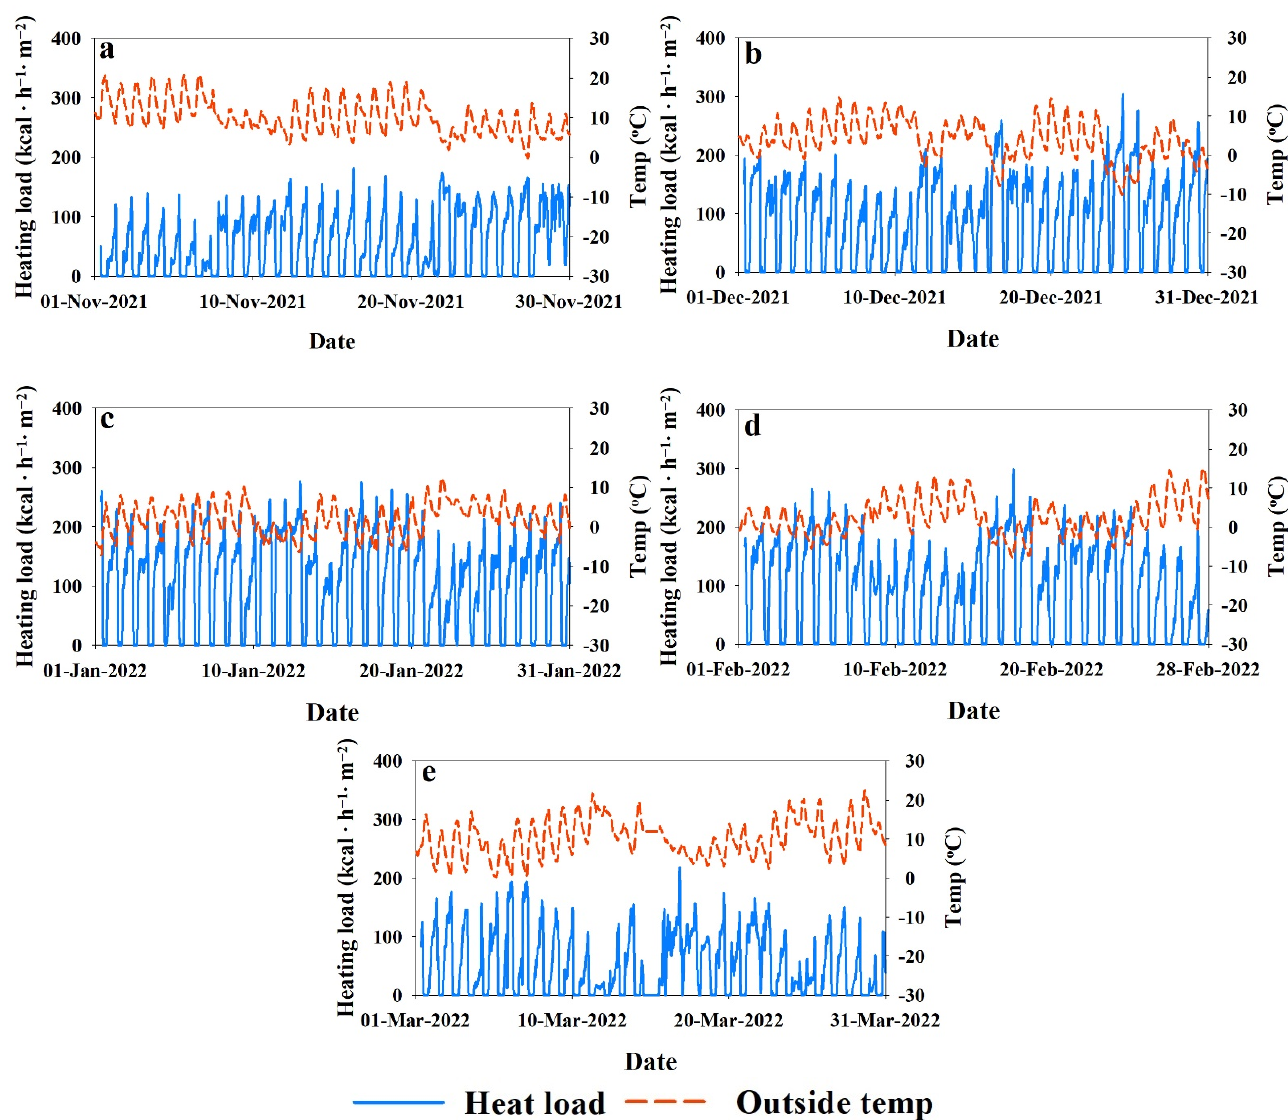
Figure 8. Greenhouse heat load with ambient weather air temperature in ( a ) November 2021, ( b ) December 2021, ( c ) January 2022, ( d ) February 2022, and ( e ) March 2022. ( b ) December 2021, ( c ) January 2022, ( d ) February 2022, and ( e ) March